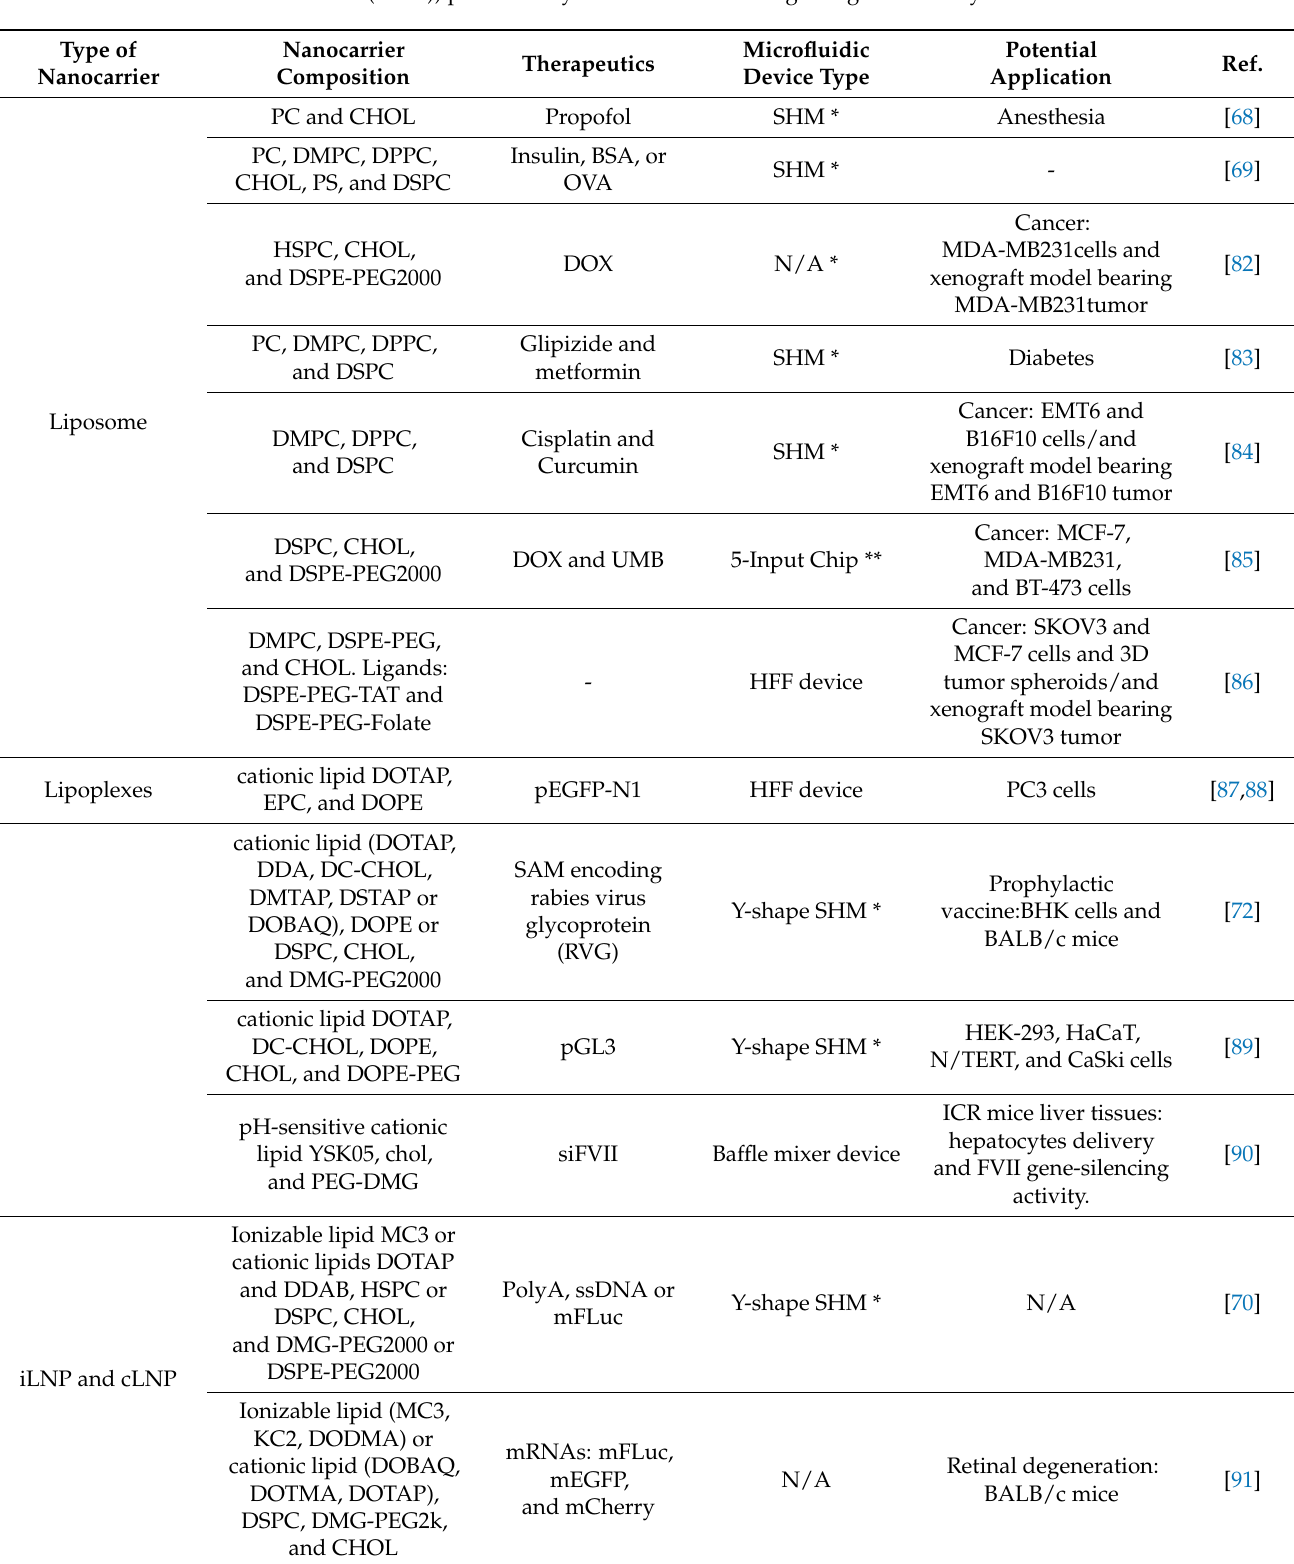
Table 1. Lipid-based nanocarrier systems (liposome, lipoplex, cationic LNP (cLNP), and ionizable LNP (iLNP)) produced by microfluidics for drug and gene